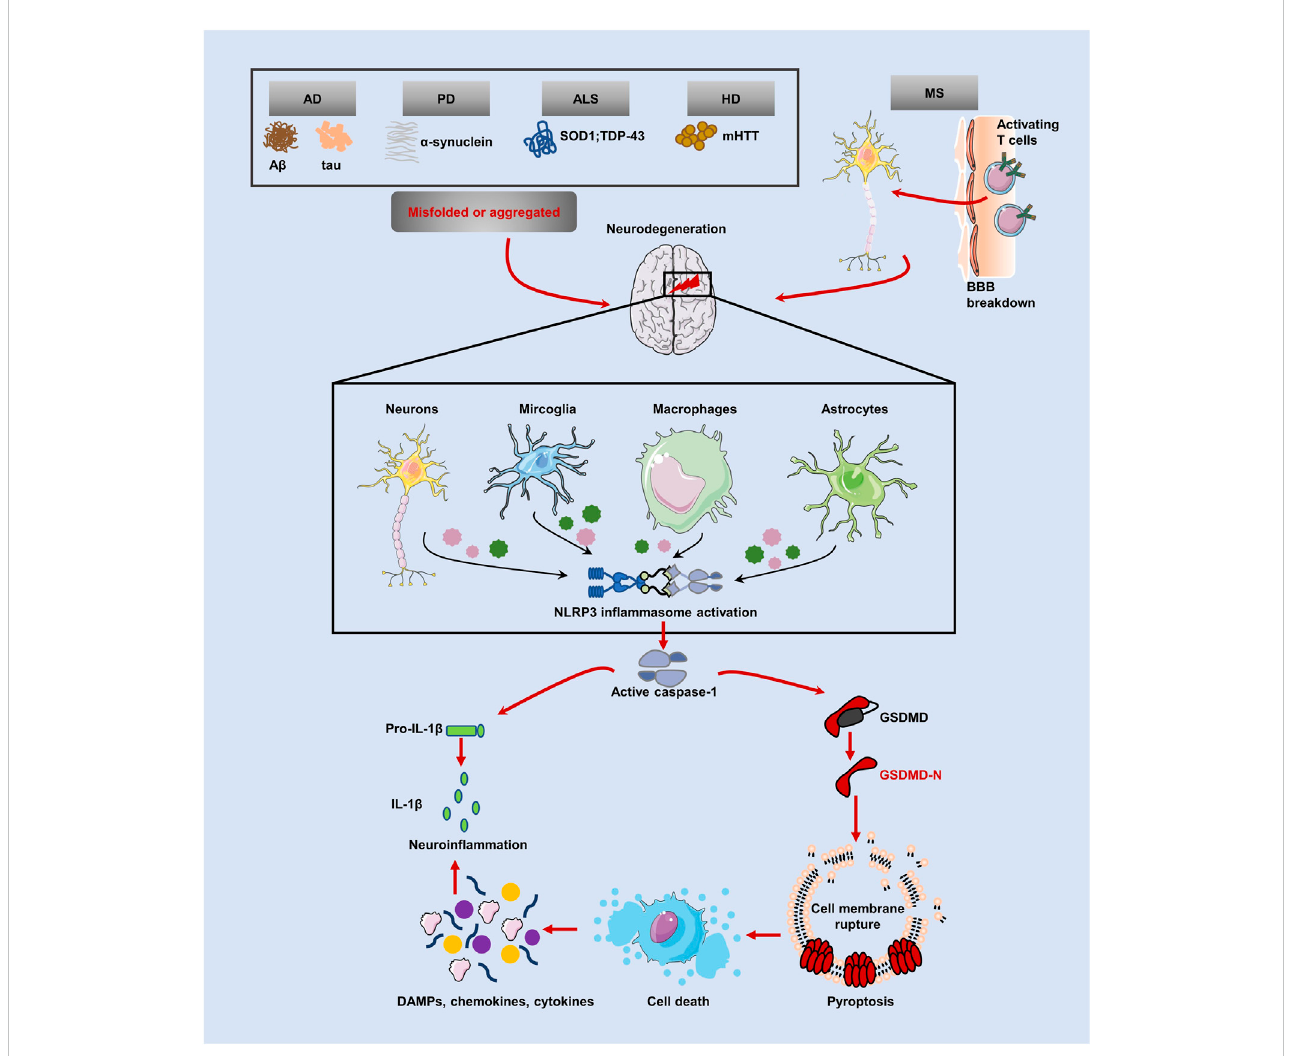
FIGURE 3 Relationship between pyroptosis and NDs. In fl ammasomes can be activated in several NDs, including AD, PD, ALS and HD, with protein misfolding and abnormal aggregation (accumulation of amyloid A β , hyperphosphorylated tau protein and a -synuclein aggregates) and autoimmune